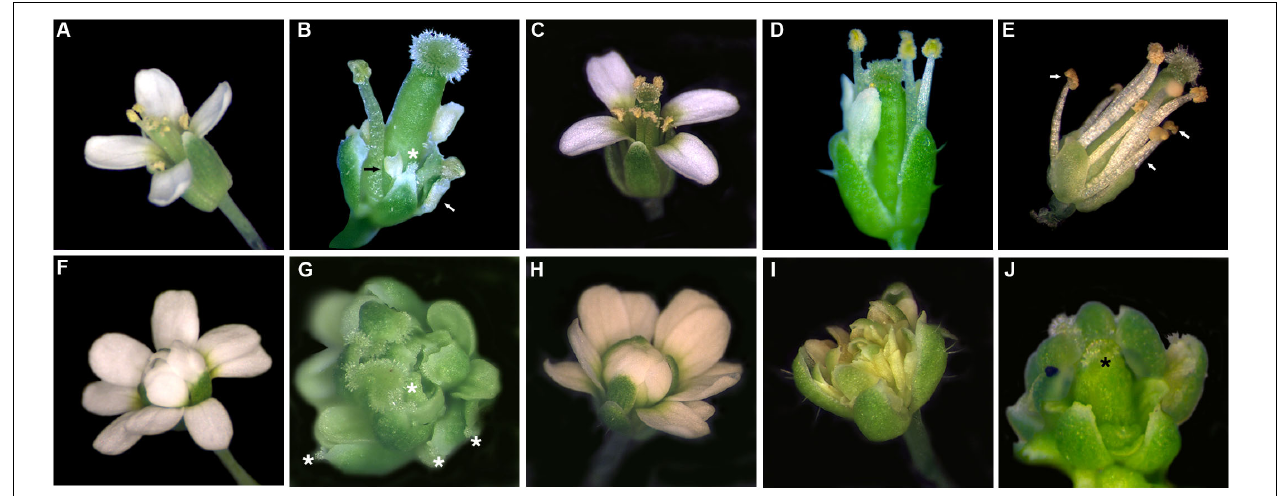
FIGURE 4 | Flowers of plants expressing: (B,G) 35S:AtAG, (C, H) 35S:OsMADS58, (D, I) 35S:OsMADS3 + S 109 and (E, J) 35S:OsMADS3 in WT (B–E) and ag-3 (G–J) backgrounds, compared to WT (A) and ag-3 mutant (F) . Ectopic stigmas on sepals (white asterisks), petal-to-stamen conversion (white arrows) and meristem determinacy recovery with formation of carpel-like organs (black asterisk) are